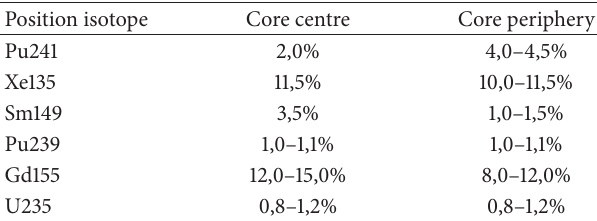
Figure 10: Uncertainty on local isotopic concentrations for some Sm149 and Pu239 at 48000 MW ⋅ d/t (% at 1𝜎 ). Table 1: Summary of isotopic concentrations